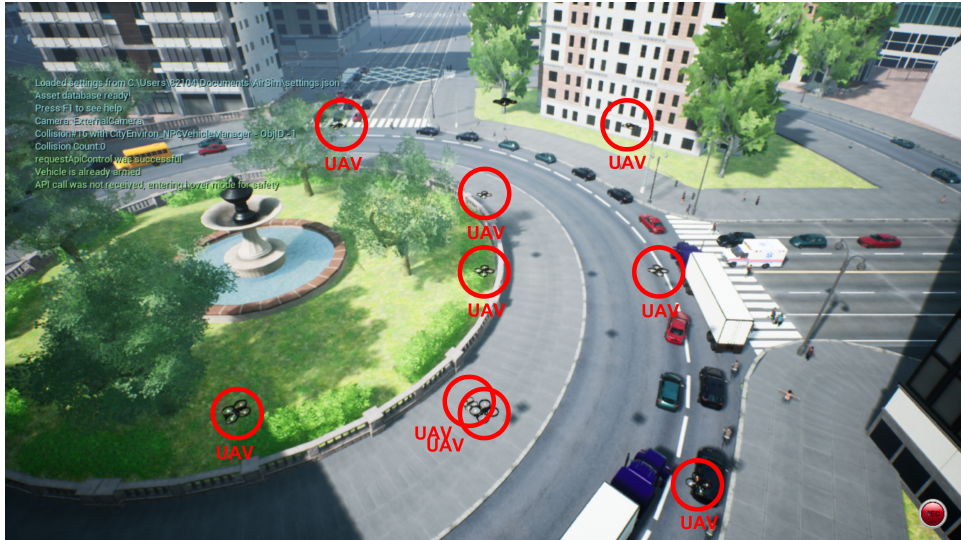
Figure 10. Simulation results of UAV topology control in